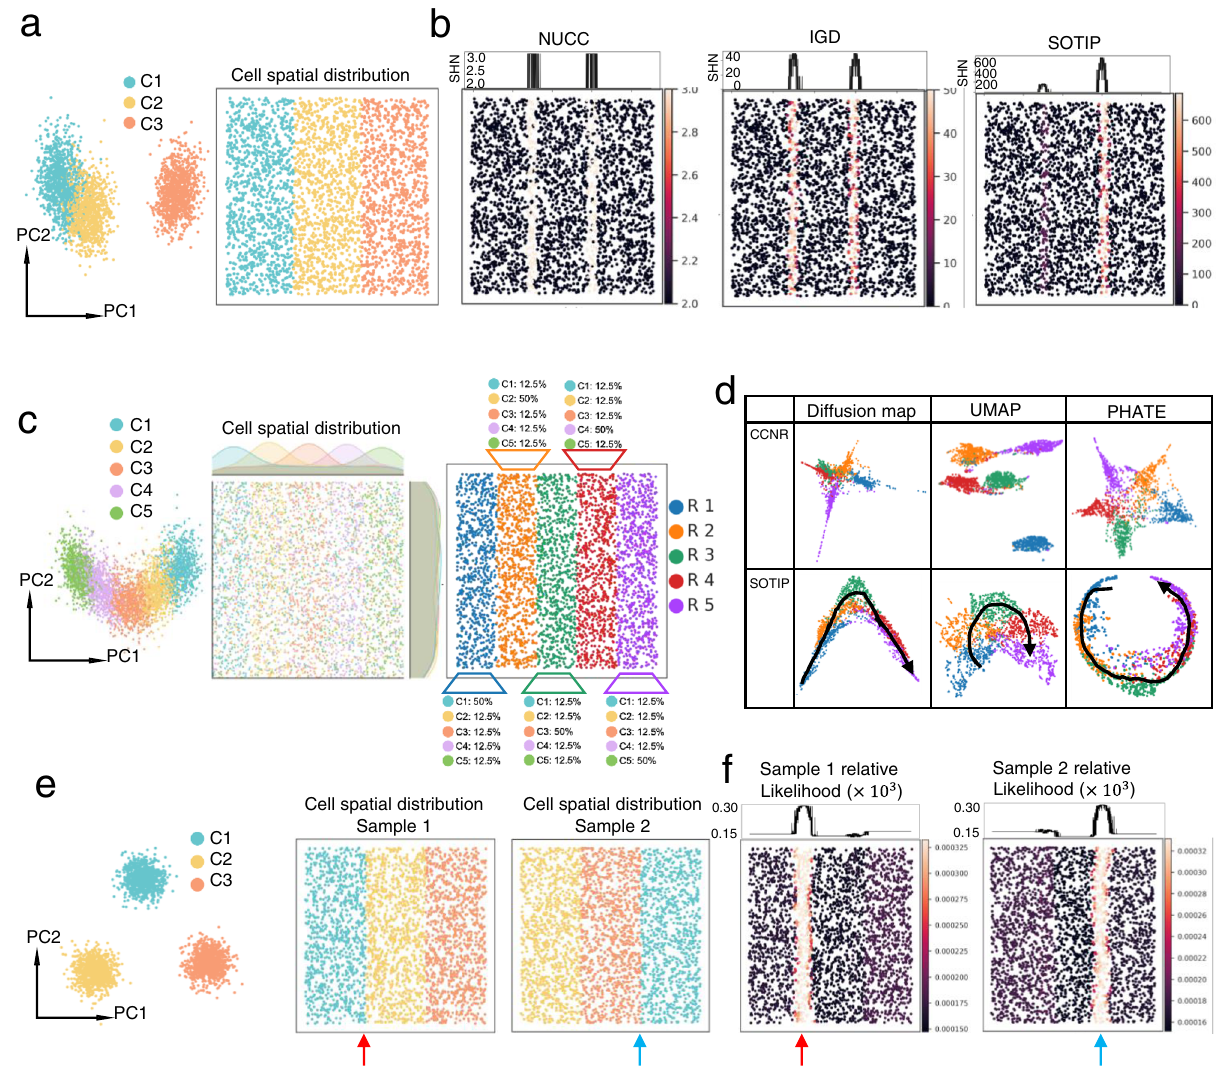
Fig. 2 | Simulation study. a PCA plot (left) and spatial distribution (right) of simulation data 1. In both plots, each point represents a cell. Both plots share the same color-coding scheme. b Comparison of NUCC (left), IGD (middle) and SOTIP (right)ofSHNquanti fi cationperformanceonsimulationdata1.Eachpanelconsists of the two parts, the top part shows the SHN value of each MECN as a function of horizontalcoordinate,and thebottom partshowsthesame setofcellswithspatial coordinatesasinFig.2aright,coloredaccordingtoSHNvalueofassociatedMECN. c PCA plot (left), spatial distribution (middle) and tissue regions (right) of simula- tion data 2. In all plots, each point represents a cell. PCA plot (left) and spatial distribution (middle) share the same color-coding scheme, different with tissue region (right). d MECN graphs generated by CCNR (top row) and SOTIP (bottom row) are embedded with different algorithms, i.e. diffusion map (left column), UMAP (middle column) and PHATE (right column). In each embedding plot, each